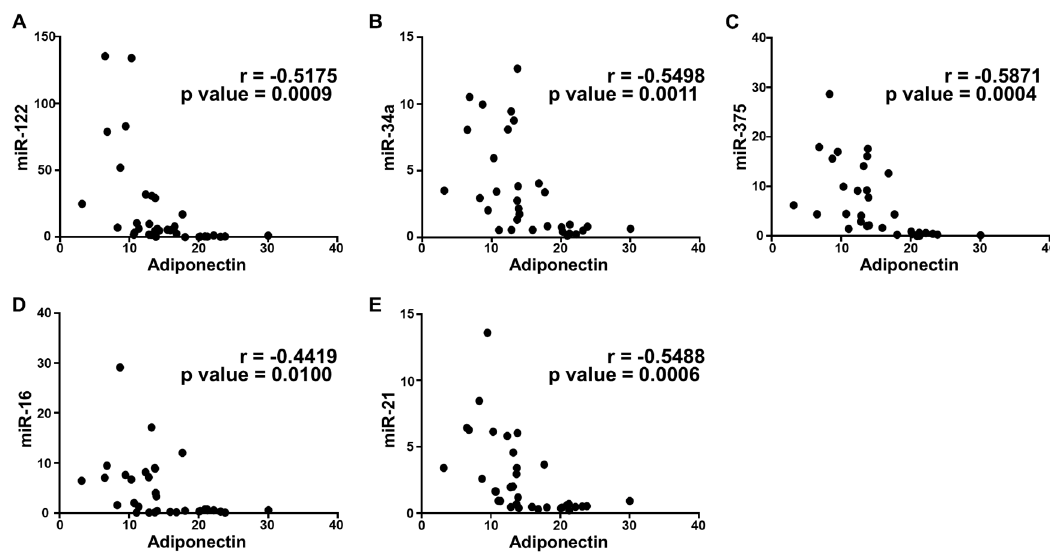
Figure 5. Correlation analysis of adiponectin with circulating miRNAs expression. Correlation was determined using Pearson’s r coefficient choosing two tailed p -value to demonstrate significance (alpha = 0.05). Scatter dot plot between adiponectin and the following: ( A ) miR-122; ( B ) miR-34a; ( C ) miR-375; ( D ) miR-16; and ( E ) miR-21. Each plot independently shows corresponding correlation coefficient (r value) and significance ( p value). A negative correlation coefficient suggests an inverse correlation. Table 3. Diagnostic performance of predictors of NAFLD assessed by ROC curve analysis. Biomarkers